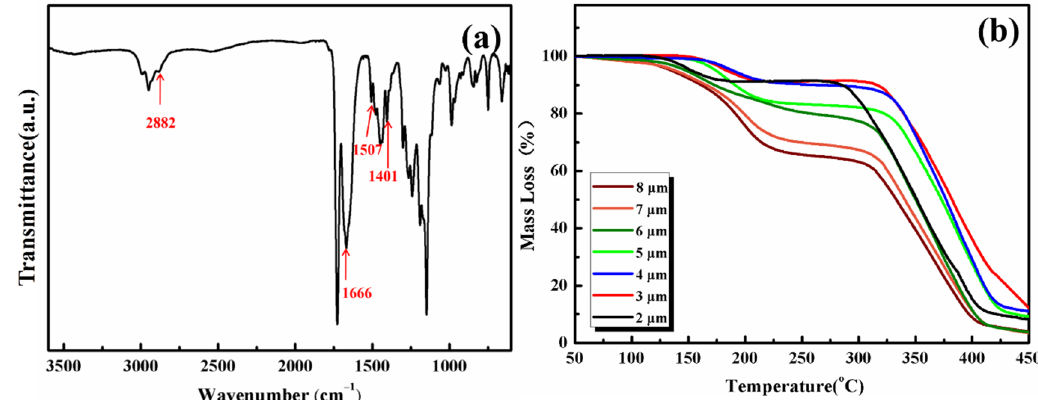
Figure 8. ( a ) FTIR analysis of the MMA-MAc-DAM-MA coating thicker than 4 µ m, ( b ) thermogravimetric analysis of the MMA-MAc-DAM-MA coating with different thicknesses.